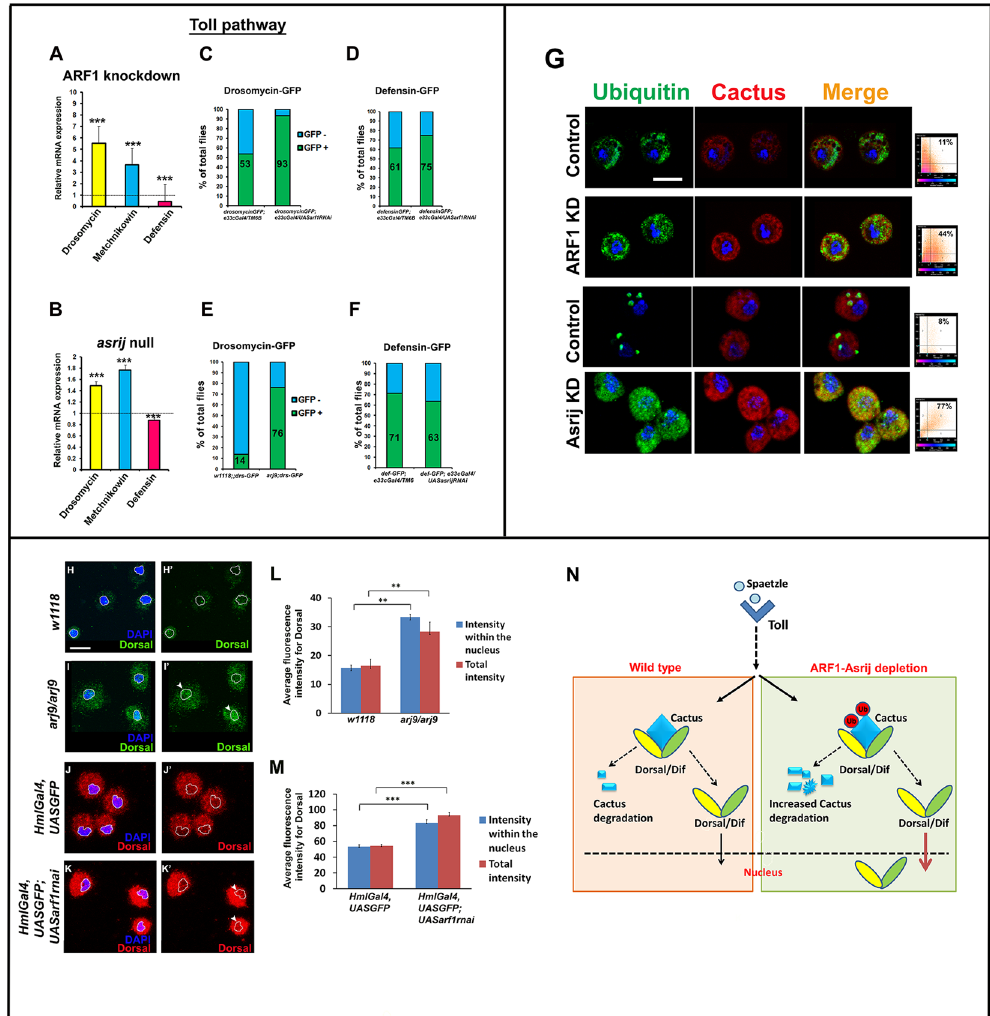
Figure 3. ARF1 and Asrij negatively regulate Toll pathway- mediated immune response. ( A , B ) Quantification of Toll pathway-governed antimicrobial peptide expression by qRT-PCR analysis shows that Drosomycin and Metchnikowin are upregulated and Defensin is downregulated in arf1 knockdown ( A ) and asrij null mutant ( B ) larvae. ( C – F ) Quantification for the total percentile of flies expressing the Toll pathway reporters - Drosomycin-GFP and Defensin-GFP in flies with e33cGal4 -mediated arf1 knockdown ( C , D ) or asrij null ( E ) or e33cGal4 -mediated asrij knockdown ( F ) respectively. ( G ) Images showing increased colocalization of Cactus and Ubiquitin in arf1 or asrij knockdown circulating larval hemocytes as compared to respective controls, also indicated by adjacent co-localization plots. ( H ) Images showing higher Dorsal specific signal in the entire hemocyte as well as in DAPI stained region (nucleus) for the asrij null ( arj9 / arj9 ) and arf1 knockdown ( HmlGal4 , UASGFP; UAS arf1rnai ) larvae as compared to the respective controls ( w1118 and HmlGal4 , UASGFP ). White dotted line indicates nuclear area under consideration. Arrowheads mark nuclei with higher Dorsal signal ( I , J ) Quantification of the fluorescence intensity for Dorsal staining in the entire cell as well as in the DAPI stained area of the cell for asrij null ( I ) and arf1 knockdown hemocytes (n = 10) ( J ). ( K ) Model indicating the suggested role of the ARF1-Asrij endocytic axis in regulating the Toll pathway. Error bars indicate standard error of mean. ** indicates P < 0.01 and *** indicates P-value < 0.001. Scale Bar: ( G , H ) 10 μ